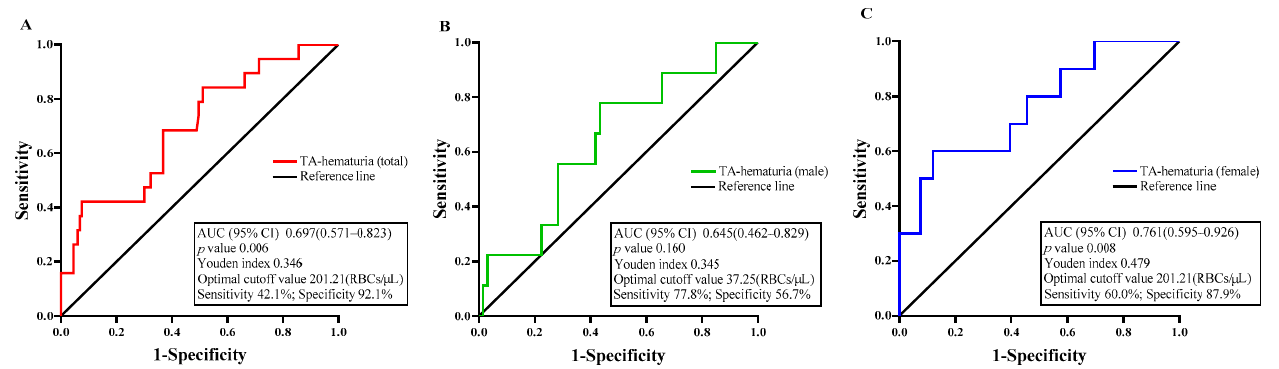
Figure 5. The value of the time-averaged hematuria (TA-hematuria) level in predicting renal prognosis. ROC curve analysis evaluates the predictive value of TA-hematuria level for the poor renal outcomes ( A ) in total participants, ( B ) in males, and ( C ) in females with IgA nephropathy.